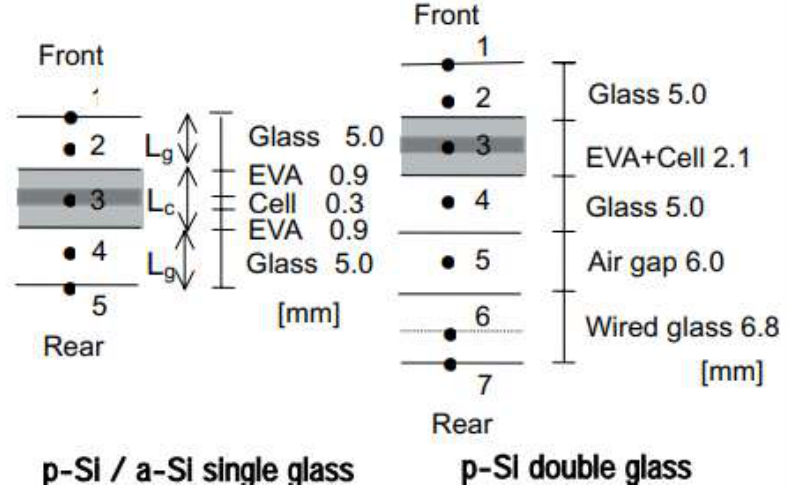
Figure 3. One-dimensional model for single- and double-glass semi-transparent PV glazing system [72].